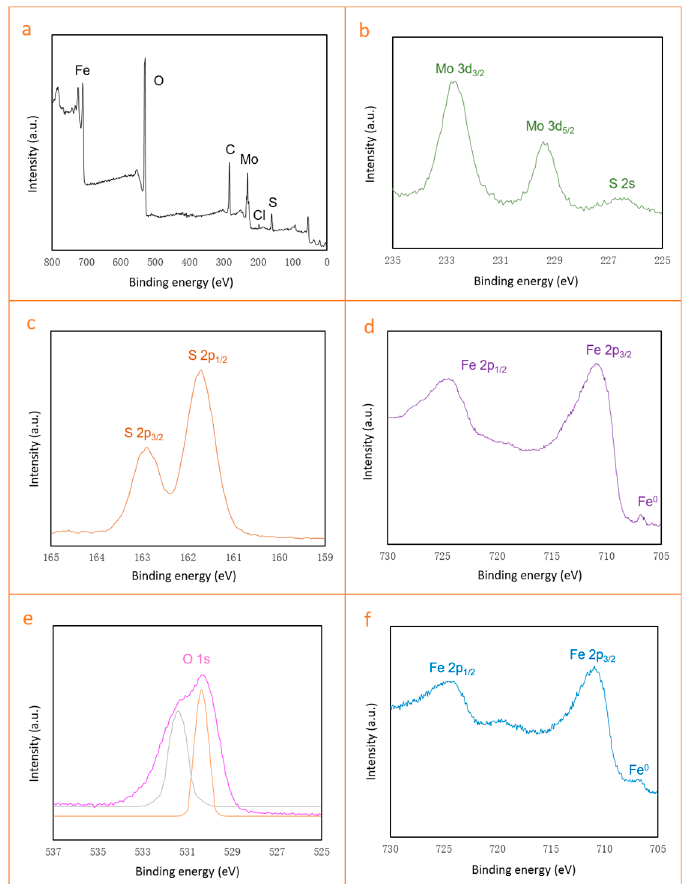
Figure 6. ( a ) The overall XPS spectrum of the MFNNs and individual ( b ) Mo 3d, ( c ) S 2p, ( d ) Fe 2p, and ( e ) O 1s XPS spectrums of the MFNNs, as well as ( f ) the Fe 2p XPS spectrum of bare nZVI.